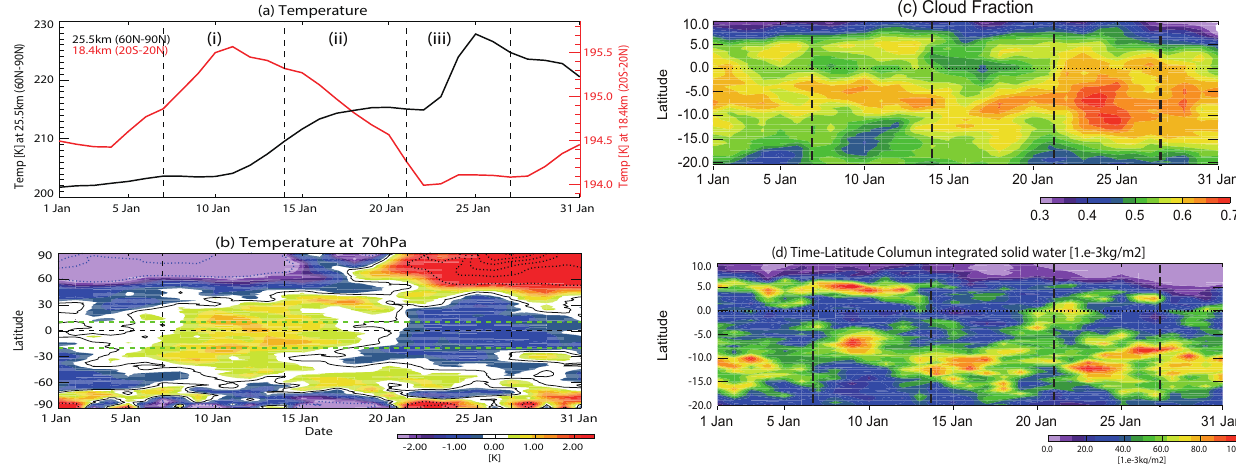
Figure 2. (a) Same as Fig. 1a but for simulated zonal mean temperature from 1 to 31 January 2010. (b) Time–latitude (90 ◦ N–90 ◦ S) section of simulated temperature anomaly (K) at 70hPa with respect to the January 2010 monthly mean at each latitude. The solid contour indicates zero anomaly and the dotted contours indicate − 2.5K and 2.5K. The light green horizontal dashed lines indicate the latitudinal region of (c) and (d) . (c) Time–latitude (20 ◦ S–10 ◦ N) section of simulated zonal mean column-integrated cloud fraction. (d) Same as (c) but for column- integrated ice cloud (10 − 3 kg m − 2 ). The four vertical dashed lines in (a–d) are 7, 14, 21 and 27 January; the periods between the lines are the (i) initial, (ii) transition and (iii) mature phases. The horizontal dashed lines in ( b , c and d ) indicate the equator.